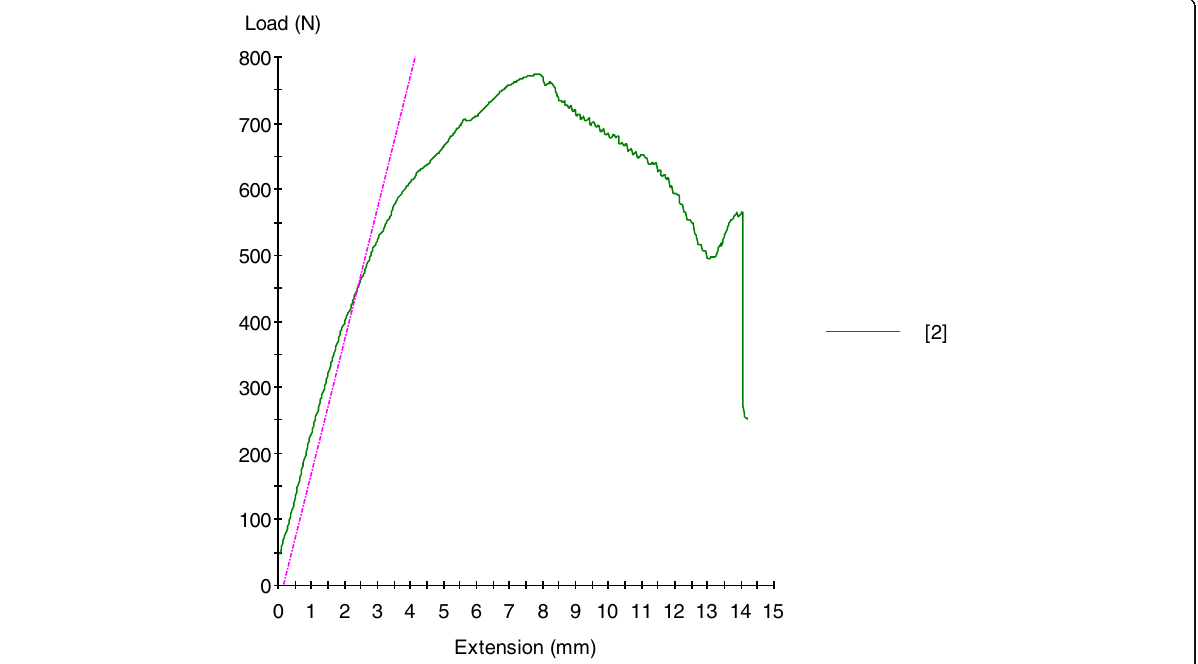
Fig. 4 Yield strength (green) vs ultimate strength (pink) of a specimen of DCP group at Stage 2. Yield load was determined for the TTP and DCP groups at the point where the curve ceased to be linear and suffered an inflection. The yield point was determined when there was a crossing between the dashed pink line and the green curve